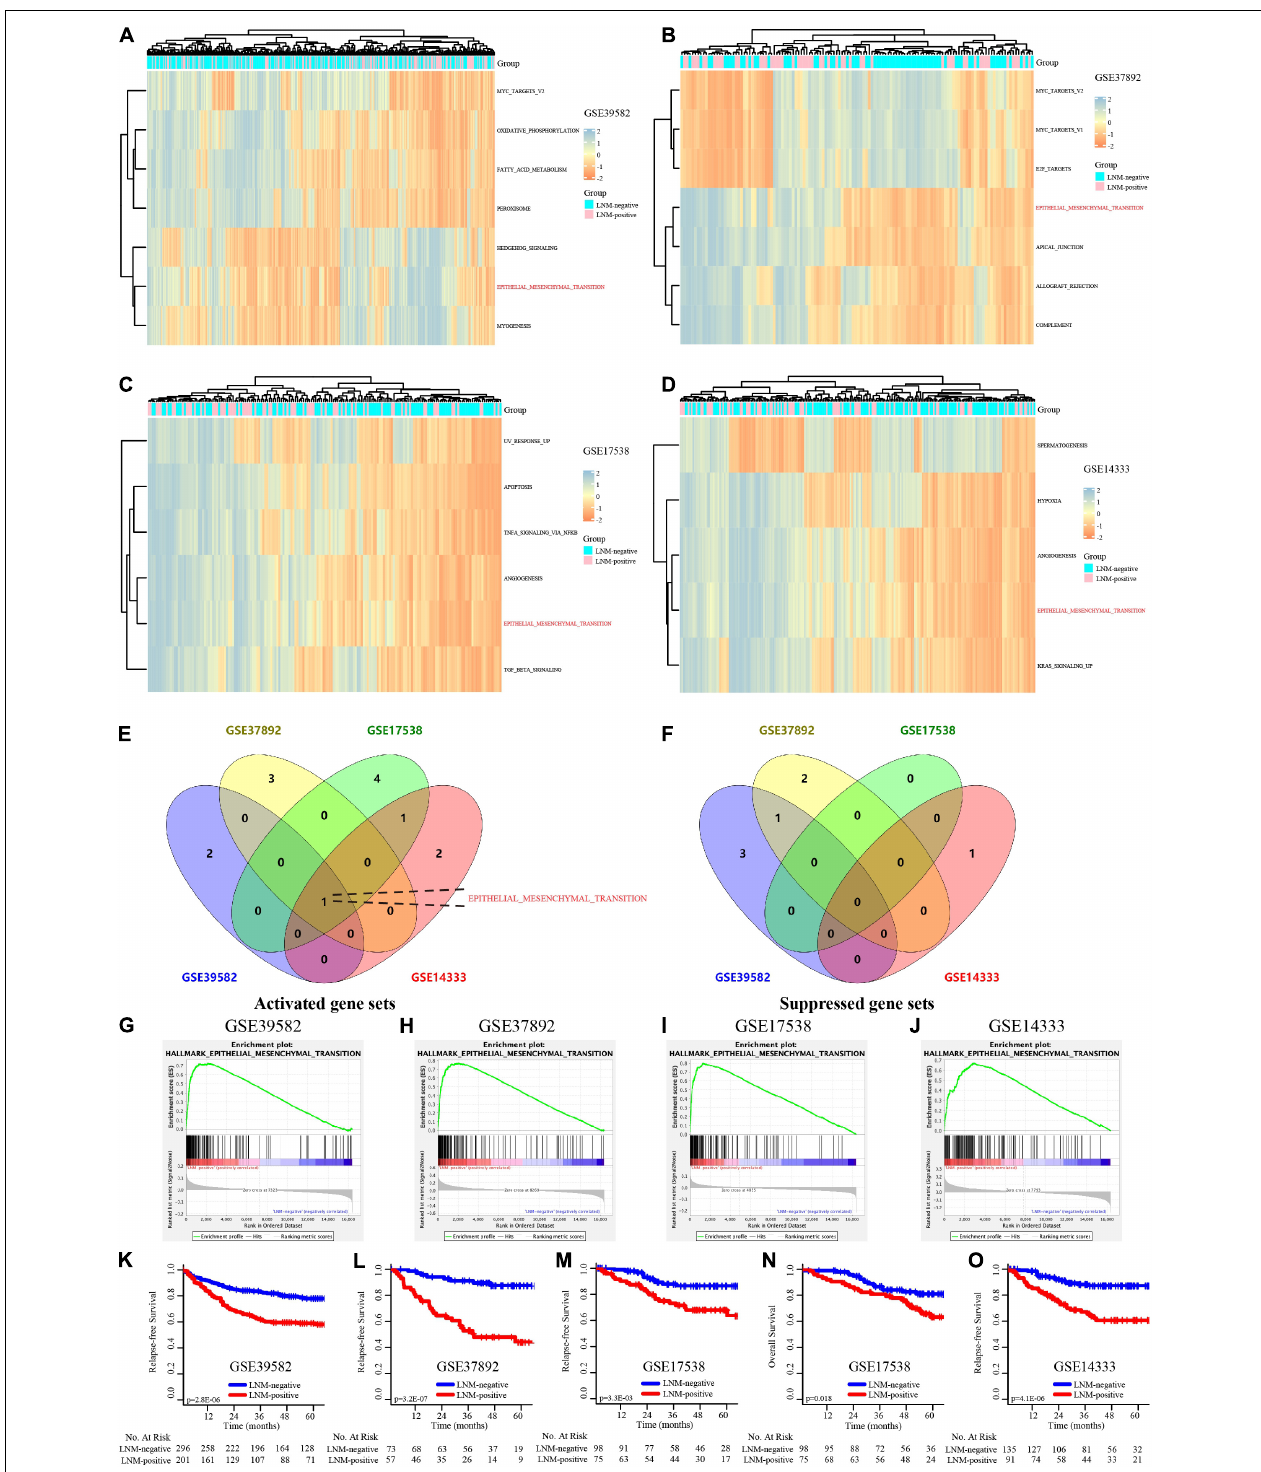
FIGURE 1 | The EMT signaling pathway is dramatically activated in the CRC transition from LNM-negative to LNM-positive. (A–D) GSVA of the GSE39582, GSE37892, GSE17538, and GSE14333 data sets. (E,F) Venn diagram of the activated (E) and suppressed (F) gene sets in the indicated data sets. (G–J) GSEA of “HALLMARK_EPITHELIAL_MESENCHYMAL_TRANSITION” of GSE39582, GSE37892, GSE17538, and GSE14333. (K–O) K–M survival analysis of LNM-negative and LNM-positive CRC patients in GSE39582, GSE37892, GSE17538, and GSE14333.